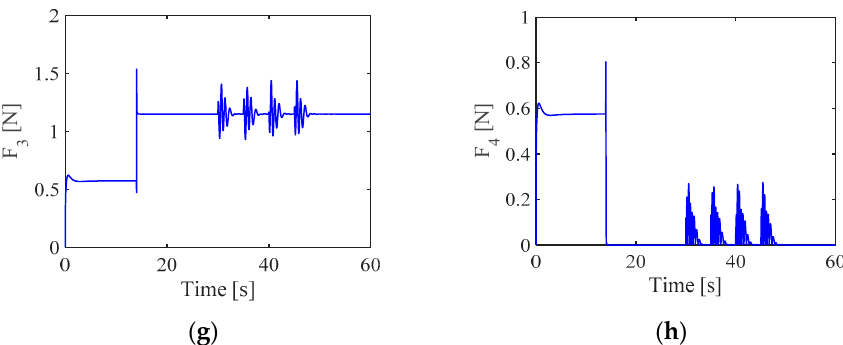
Figure 13. Detection units and forces for scenario 2: (a) fault detection of motor 1, (b) fault detection of motor 2, (c) fault detection of motor 3, (d) fault detection of motor 4, ( e ) motor 1 ′ s force, (f ) motor 2 ′ s force, (g) motor 3 ′ s force, and (h) motor 4 ′ s force.